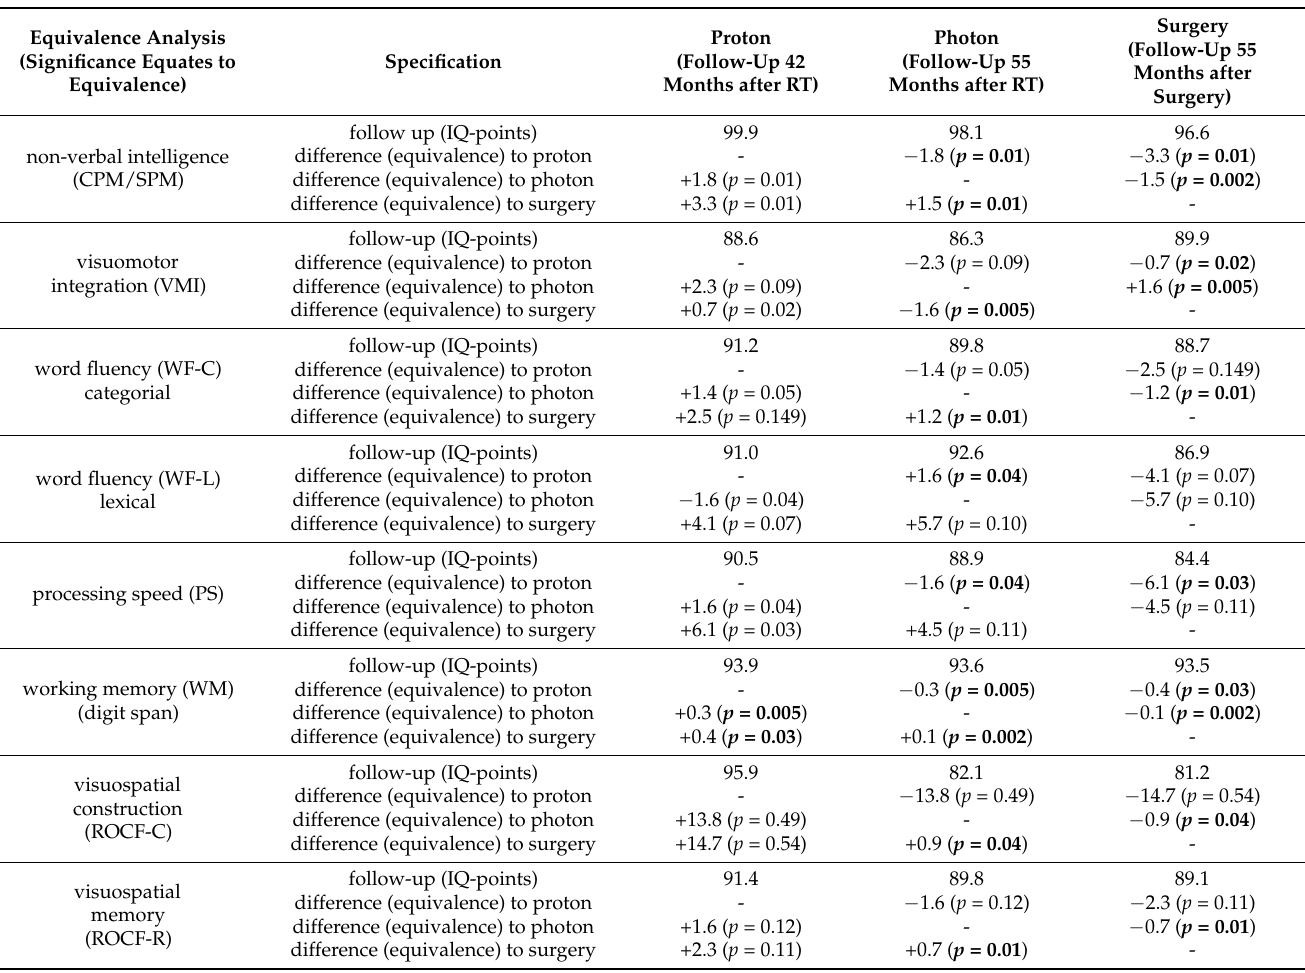
Table 3. Results of equivalence analysis (TOST = two one-sided t -tests), statistical significance accounting for equivalent results.